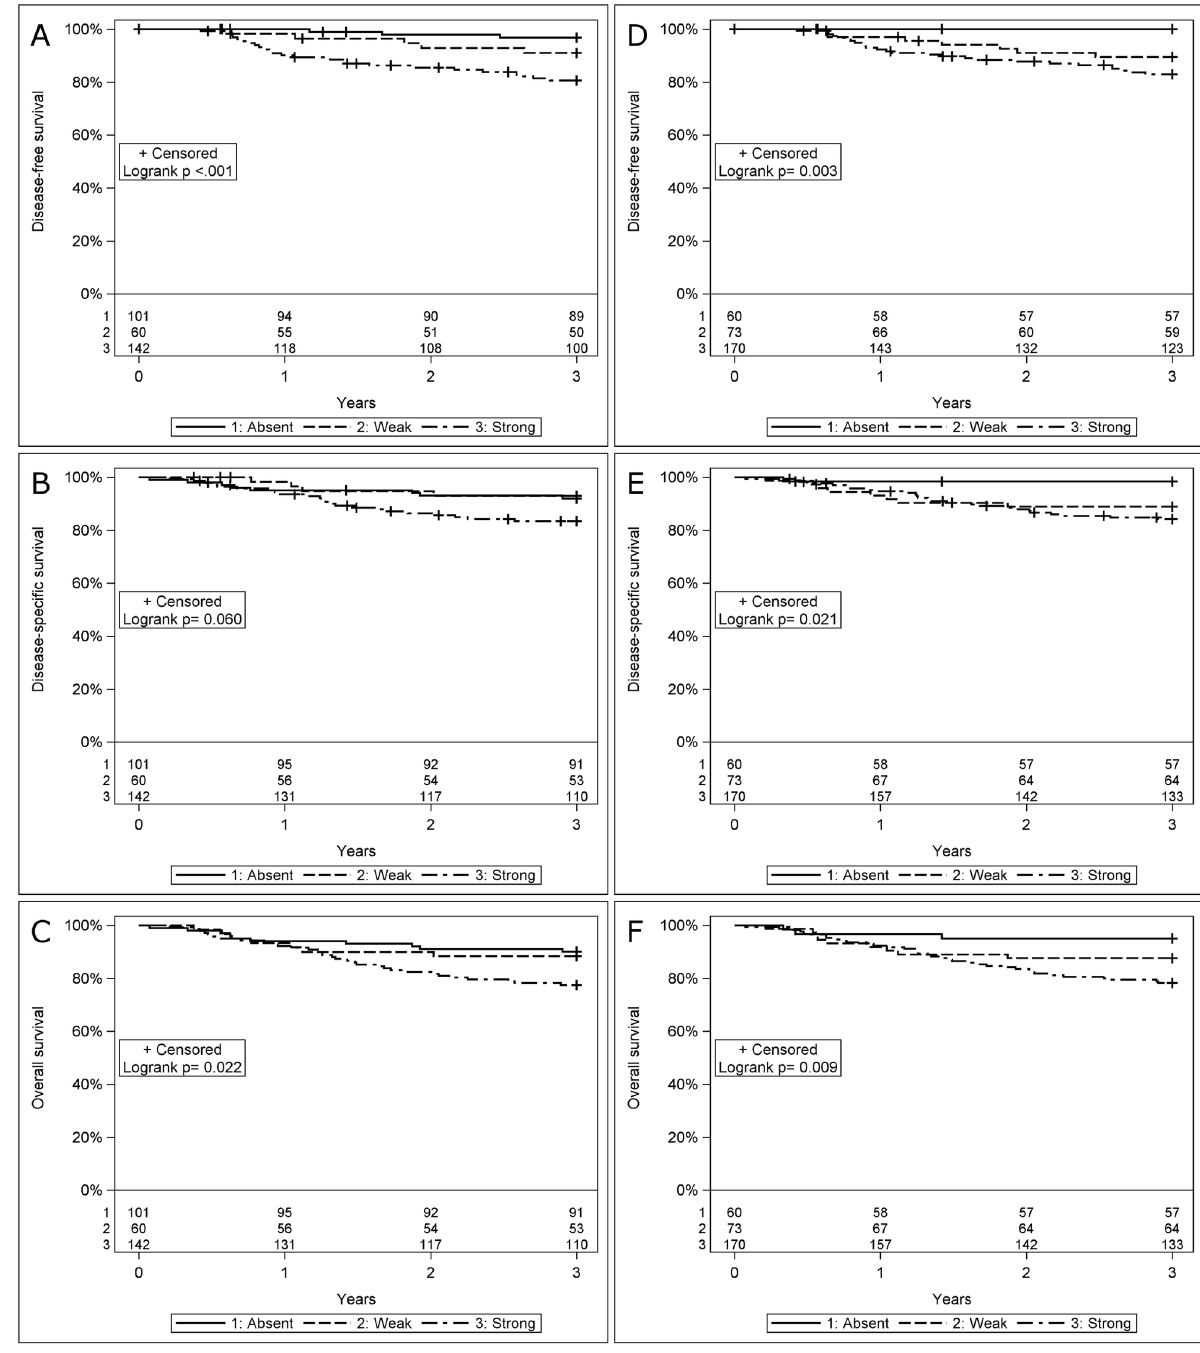
Figure 1. Kaplan-Meier curves for disease-free survival (DFS), disease-specific survival (DSS) and overall survival (OS) in patients with HPV positive oropharyngeal squamous cell carcinoma (OSCC) with known HLA class I expression. (A) DFS stratified for HCA-2 intensity, (B) DSS stratified for HCA-2 intensity, (C) OS stratified for HCA-2 intensity, (D) DFS stratified for HC-10 intensity, (E) DSS stratified for HC-10 intensity, and (F) OS stratified for HC-10 intensity. HPV class I intensity had a significant better clinical outcome than tumors with strong HLA class I intensity, while weak intensity staining presented an intermediate survival (HCA-2: DFS p<0.001; DSS p=0.060; OS p=0.022; HC-10: DFS p=0.003, DSS p=0.021 and OS p=0.009, with the log-rank test). Notably, the difference observed in the HCA-2 DSS analysis did not reach significance, although the trend was similar. doi: 10.1371/journal.pone.0077025.g001 PLOS ONE |